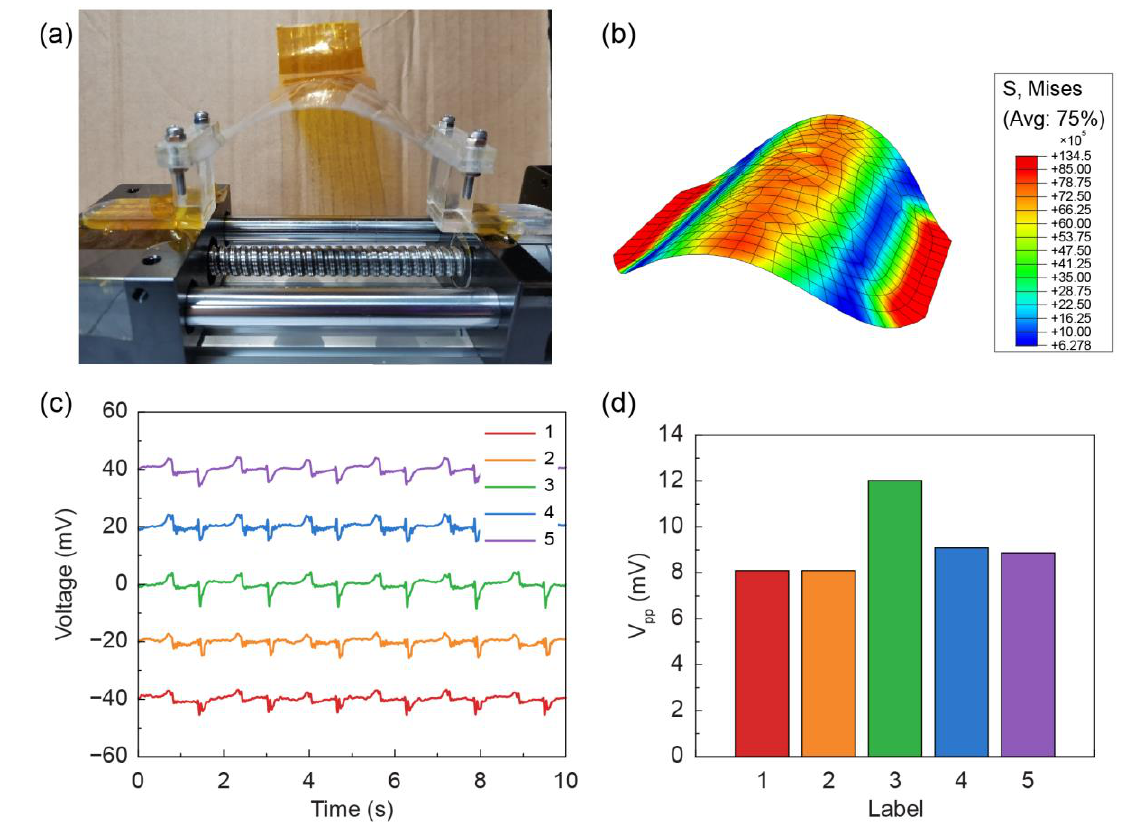
Figure 3. ( a ) Photograph of the experimental platform of periodic compressing–releasing testing and device in compressing state; ( b ) Simulation of stress distribution of the piezoelectric thin film when the free-end clamp moves to the maximum compression displacement; ( c ) The output signals of each sensor unit of the cross-shaped sensor array; ( d ) The average peak-to-peak voltage signal of five sensor units. To further prove the sensor consistency, the positive compression test was